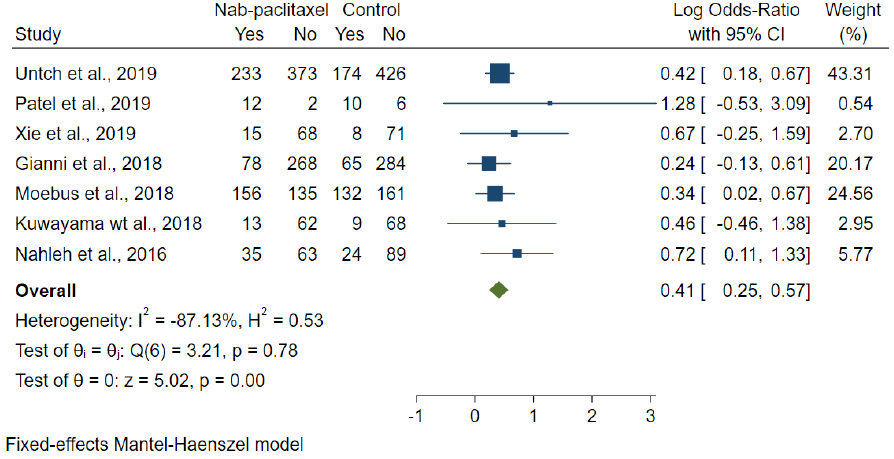
Fig. 2. Forest plot showed Pathological complete response in breast cancer